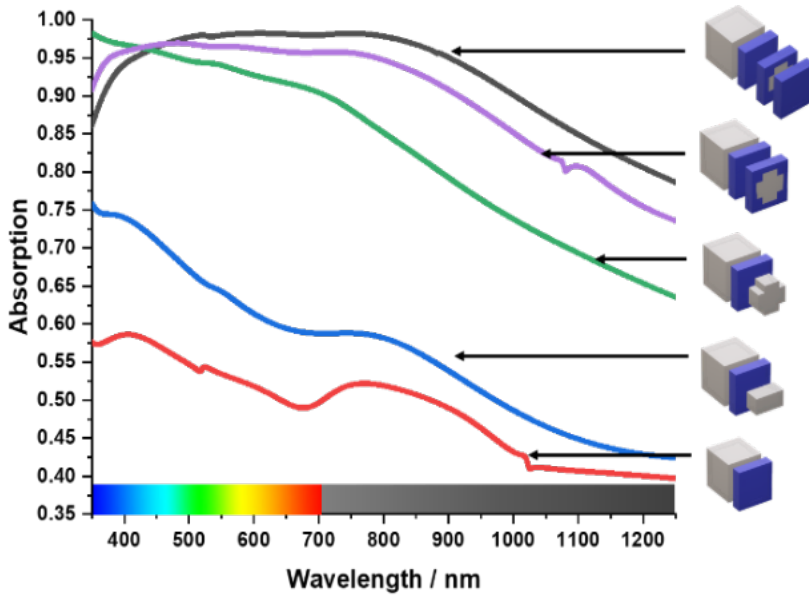
Figure 6. Design Evaluation of the proposed MA.